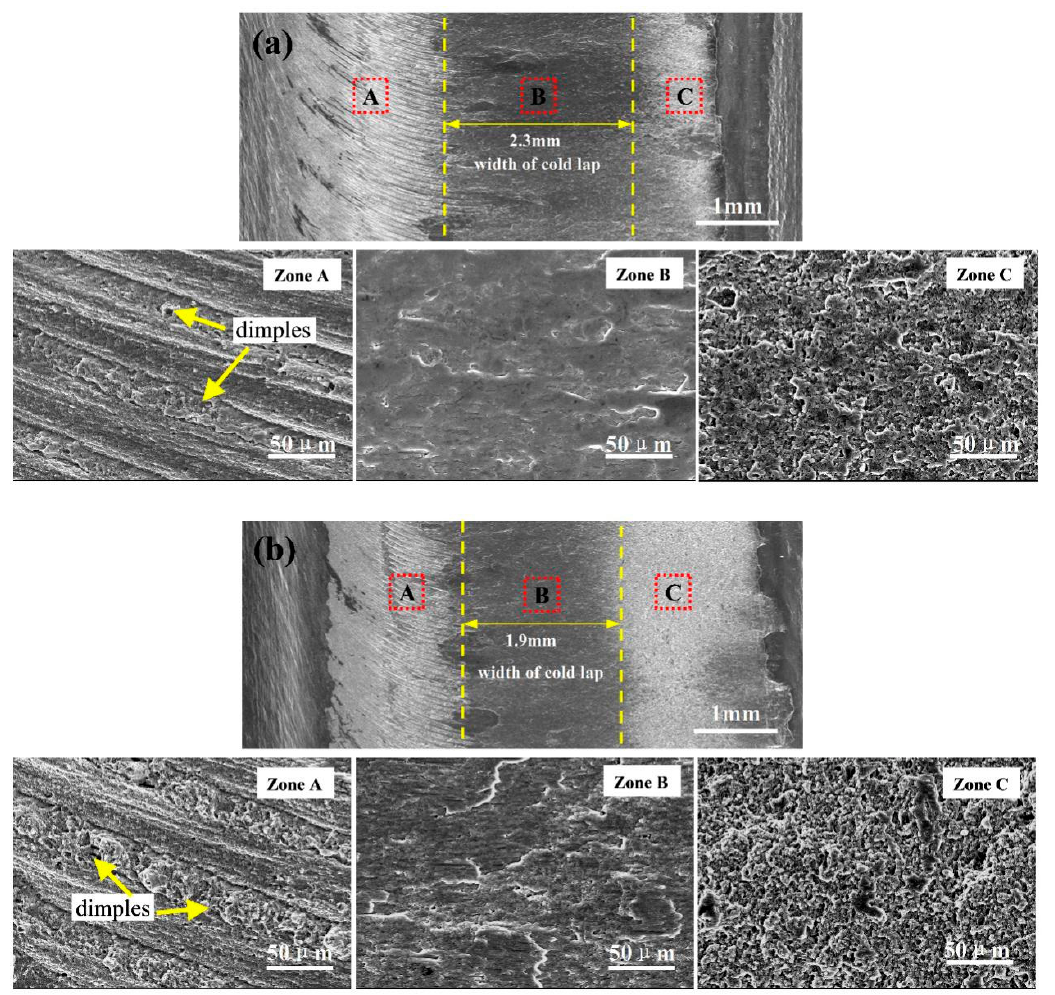
Figure 14. Fracture morphologies of the FSLW and UAFSLW joints welded by tool T2 under the lap configuration A: ( a ) FSLW and ( b ) UAFSLW.